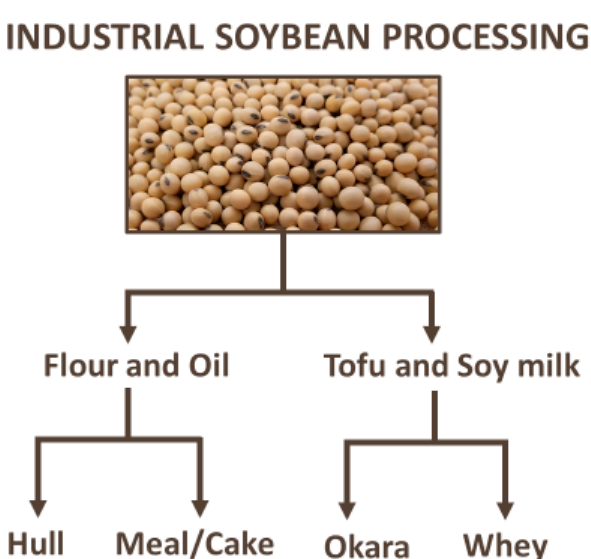
Figure 9. Industrial soybean processing and its respective products and by-products.